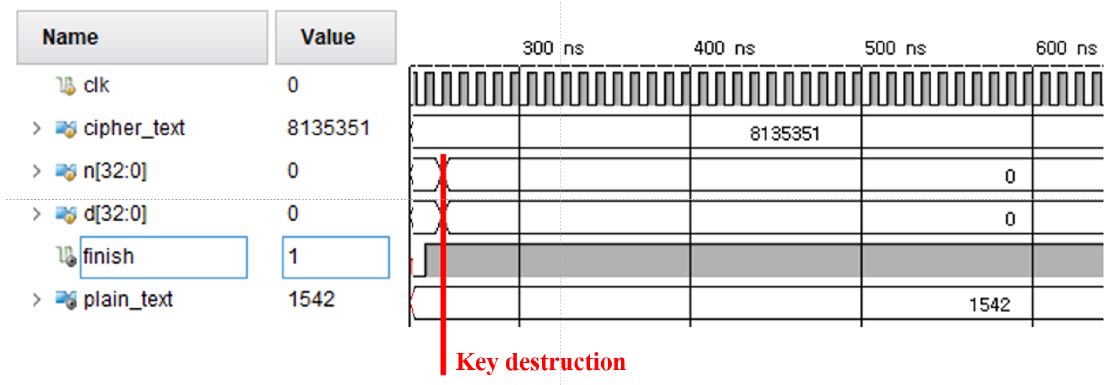
Figure 8. Decryption simulation